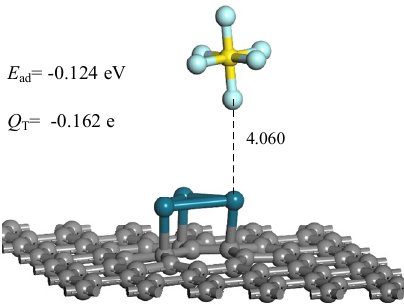
Figure 10. The most adsorption structure of SF 6 on Pd 3 ‐graphene surface (distance in Å).